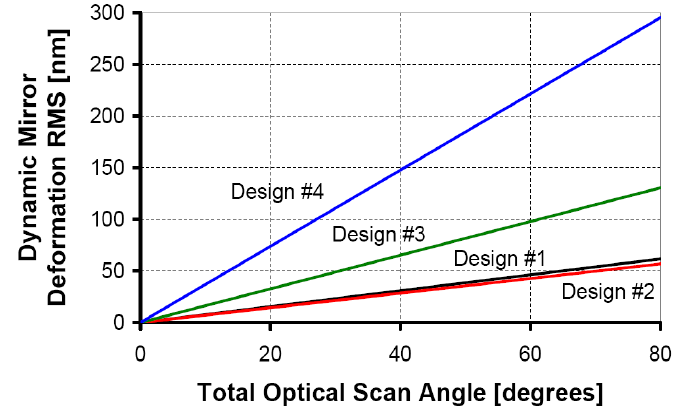
Figure 14. Finite Element Analysis based calculation of dynamic mirror deformation for all four designs.